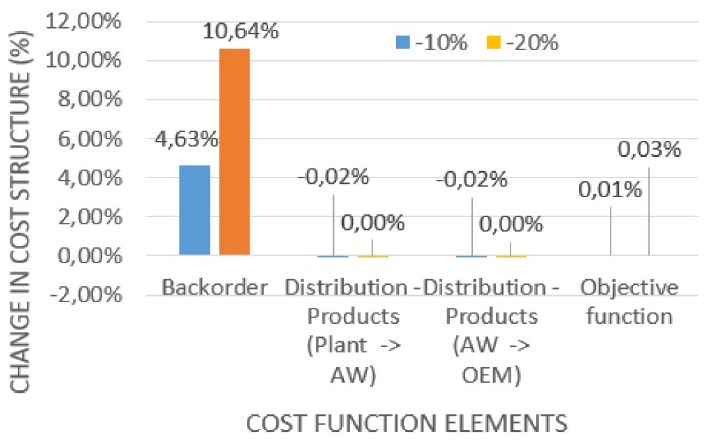
Figure 5. Maximum capacity cost impact